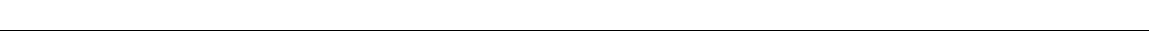
Fig. 2 GRIP1 is a substrate for dexamethasone (Dex)-induced phosphorylation by CDK9 in macrophages. a hM Φ , THP1 cells or BMM Φ were treated with Dex for the times indicated and the levels of GRIP1 (total or phosphorylated (p) at S469, S487, S493, and S499), GR, CDK9 and HSP90 as a loading control were assessed by immunoblotting (quanti fi ed in Supplementary Fig. 5a). b THP1 cells or mBMM Φ were treated with Dex ± fl avopiridol (FVP) at indicated concentrations for 2 h and GRIP1 phosphorylation was visualized by immunoblotting (quanti fi ed in Supplementary Fig. 5b). c Immortalized BMM Φ were depleted of CDK9 (single guide (sg)CDK9 vs. scrambled sgSCR control) as described in Methods and treated ± Dex for 1 h. The levels of GRIP1, phospho- (p)GRIP1, GR, CDK9 and HSP90 were assayed by western blot and quanti fi ed by densitometry; CDK9 levels or ratios of pGRIP1/GRIP1 in sgCDK9 cells are expressed relative to those in sgSCR cells ( = 1). Samples were compared by unpaired, two-tailed Student ’ s t -test; means + standard error of the mean (SEM) are shown ( n ≥ 3, * P < 0.05, ** P < 0.01). d E . coli -produced af fi nity-puri fi ed GST – GRIP1 322-631 WT and S469A/S487A/S493A/S499A (4A) were subjected to in vitro kinase assays with baculovirus-expressed cyclin T1-CDK9. GRIP1 phosphorylation was assessed by autoradiography (left) and immunoblotting (right) with Coomassie blue staining (left) or immunoblotting for GST-tag (right) showing equal loading. e BMM Φ or THP1 cells were treated ± Dex for 1 h, double cross-linked and GR immunoprecipitations (IP) performed (see “ Methods ” ). Inputs and IPs were immunoblotted for GRIP1, GR and CDK9 (with HSP90 as an input loading control). Full-size western blots are shown in Supplementary Fig. 10a –